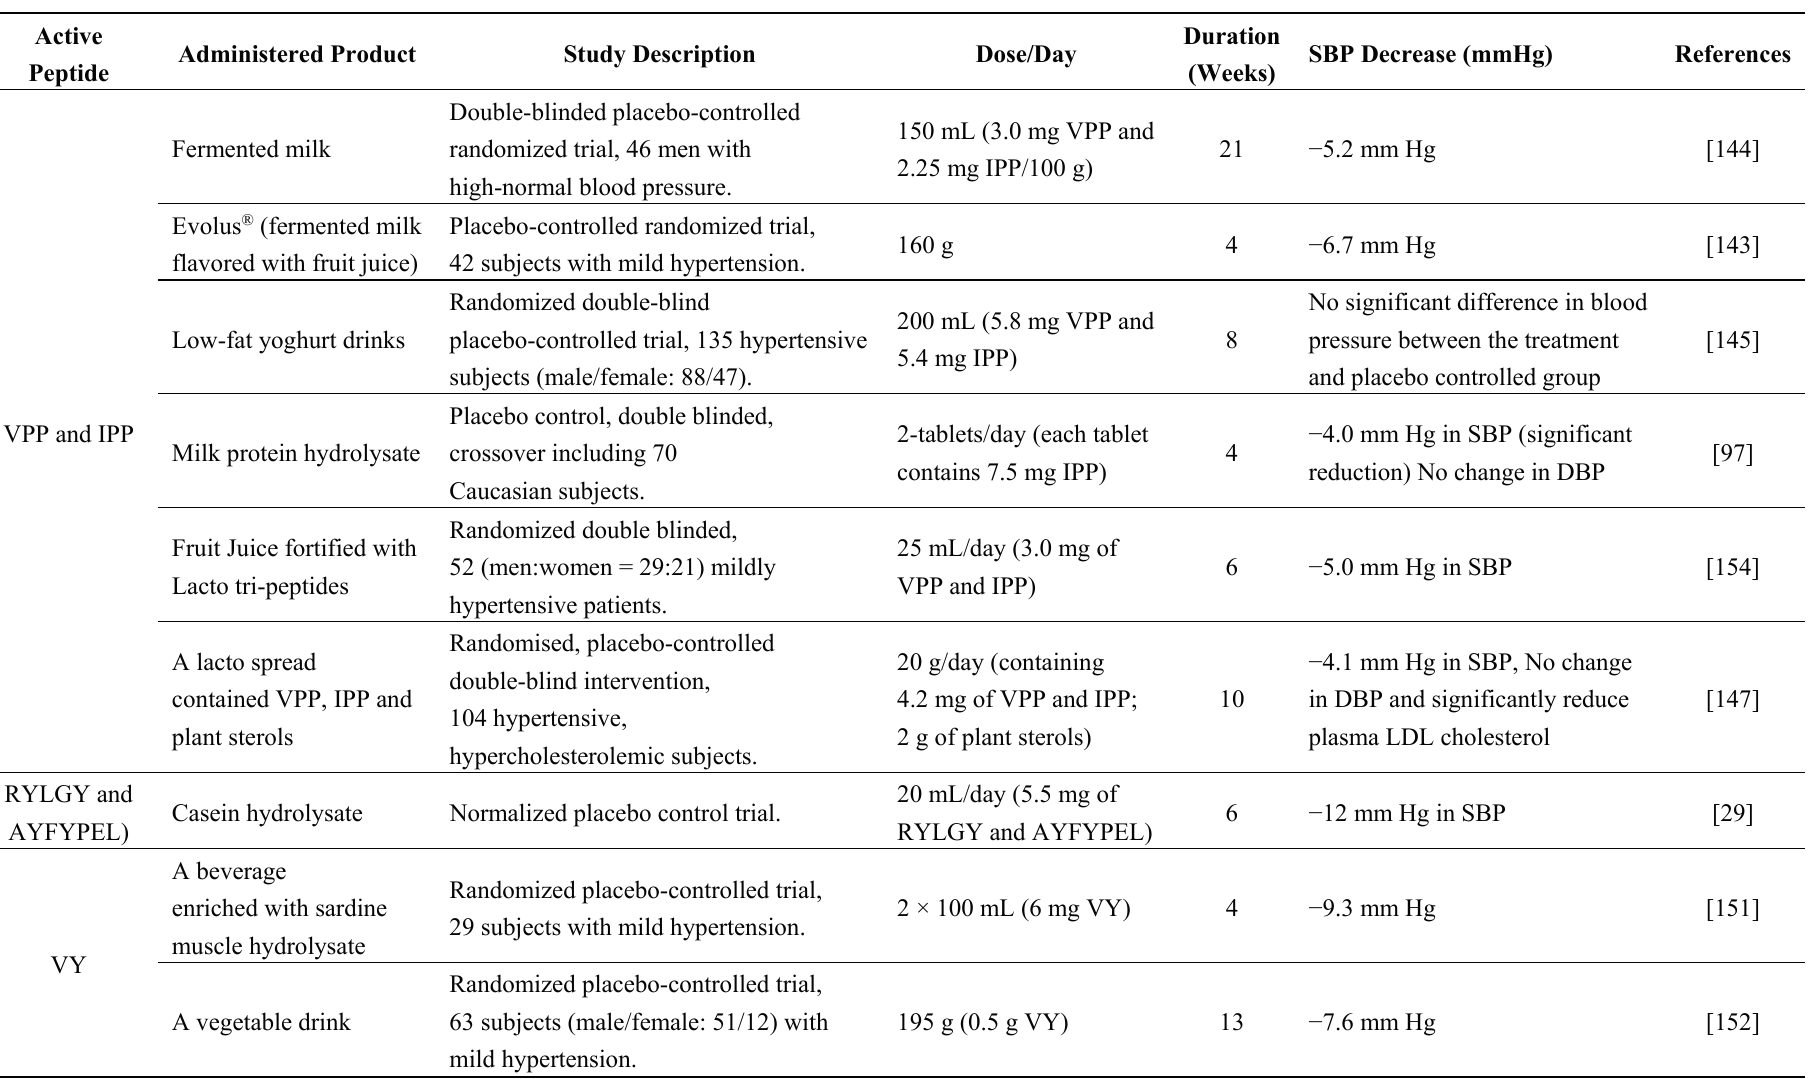
Table 2. Human clinical trials of food protein derived antihypertensive